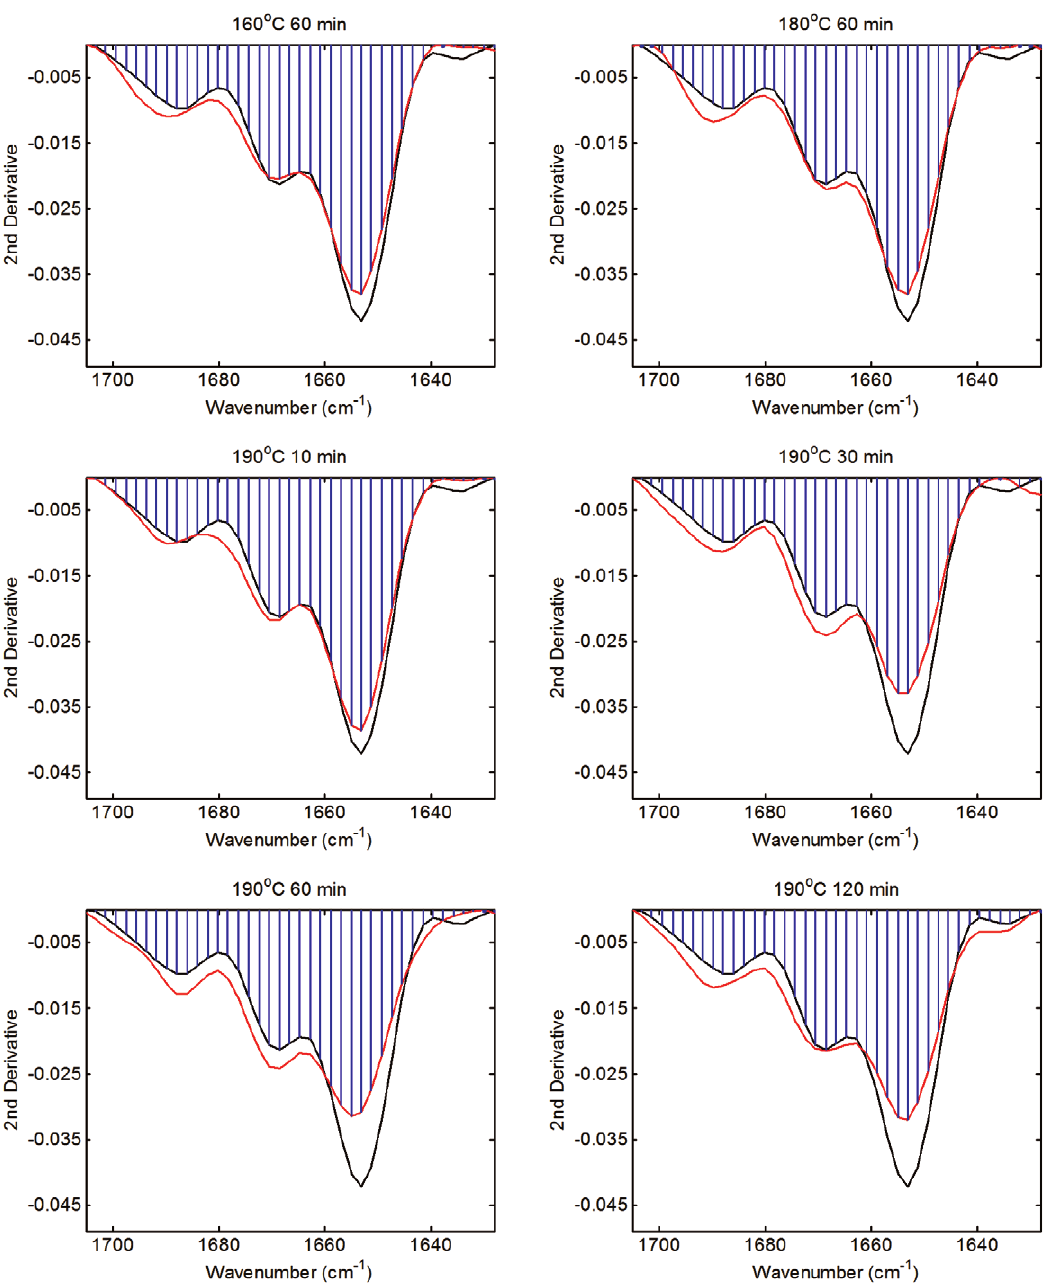
Figure 4. Amide I 2 nd derivative band overlap analysis of honeybee sponges heat treated at 160, 180 and 190 6 C for different lengths of time. Untreated sponge (black trace), treated sponge (red trace) and overlap area (blue region).